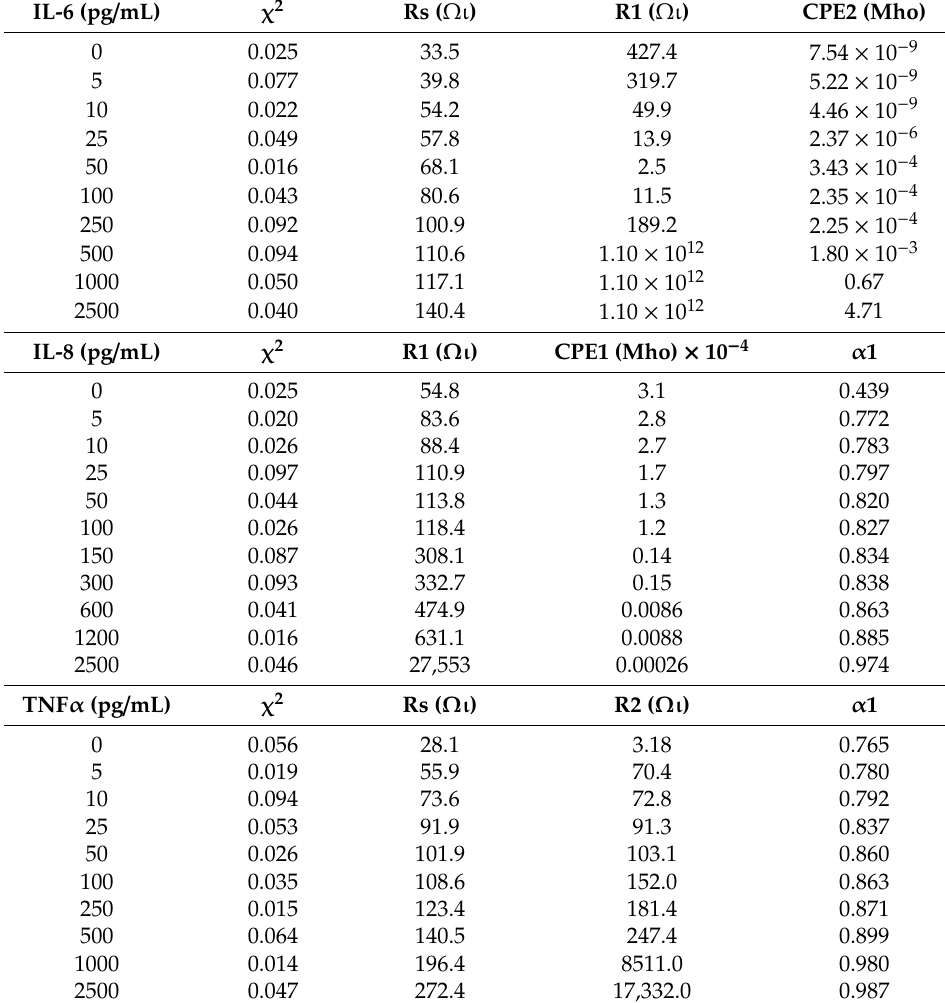
Table 2. Values of equivalent circuit elements obtained for fitting of the experimental data for various concentrations of IL-6, IL-8, TNF α : R 2 —mean square error; R1—resistance of the porous layer; R2—resistance of the ionic interface between the double layer and the solution; CPE1—double-layer capacitance; N1— n -value of a CPE1. IL-6 (pg /